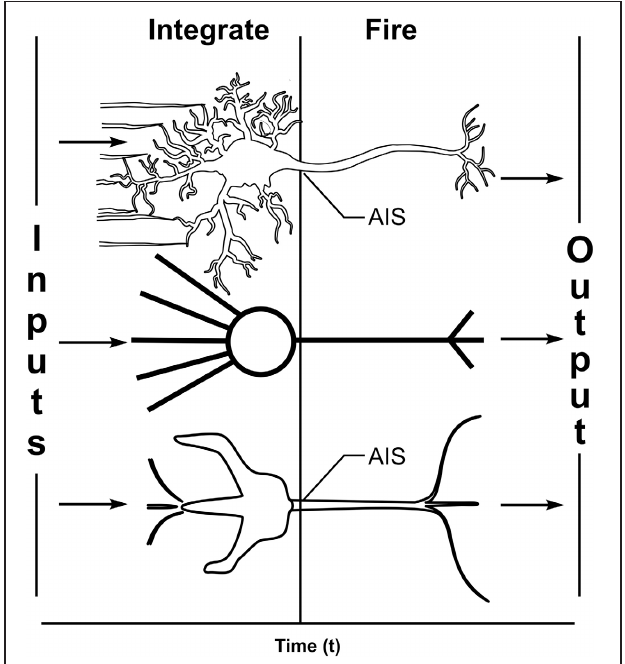
FIGURE 1 | Three characterizations of integrate-and-fire neurons. Top: Biological neuron with multiple dendrites and one cell body (soma) receive and integrate synaptic inputs as membrane potentials which are compared to a threshold at the axon initiation segment (AIS). If threshold is met, axonal spikes/firings are triggered along a single axon which branches distally to convey outputs. Middle: computer-based artificial neuron (e.g., a “perceptron,” Rosenblatt, 1962) with multiple weighted inputs and single branched output. Bottom: model neuron (see subsequent figures) showing the same essential features with three inputs on one dendrite and single axonal output which branches